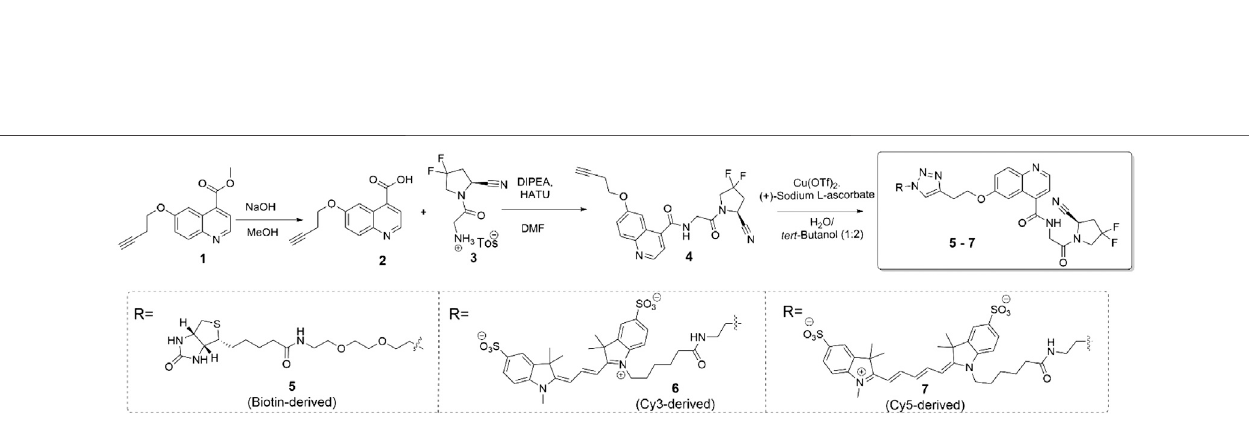
FIGURE 1 | FAP-inhibitor UAMC1110 and examples of UAMC1110 derivatives that have been reported as activity-based probes (ABPs) (Jansen et al., 2014; Lindner et al., 2018; De Decker et al., 2019; Loktev et al., 2019; Moon et al., 2020; Toms et al., 2020). (A) Parent compound UAMC1110 (Jansen et al., 2014). (B) Gallium-68 labeled radiotracer reported in 2018 (Lindner et al., 2018). (C) Gallium-68 labeled radiotracer reported in 2020 (Moon et al., 2020). (D) Fluorine-18 labeled radiotracer reported in 2019 (Toms et al., 2020). (E) Designed, selective FAP substrate reported in 2019 (De Decker et al., 2019). (F) UAMC1110-derived probes, synthesized for this